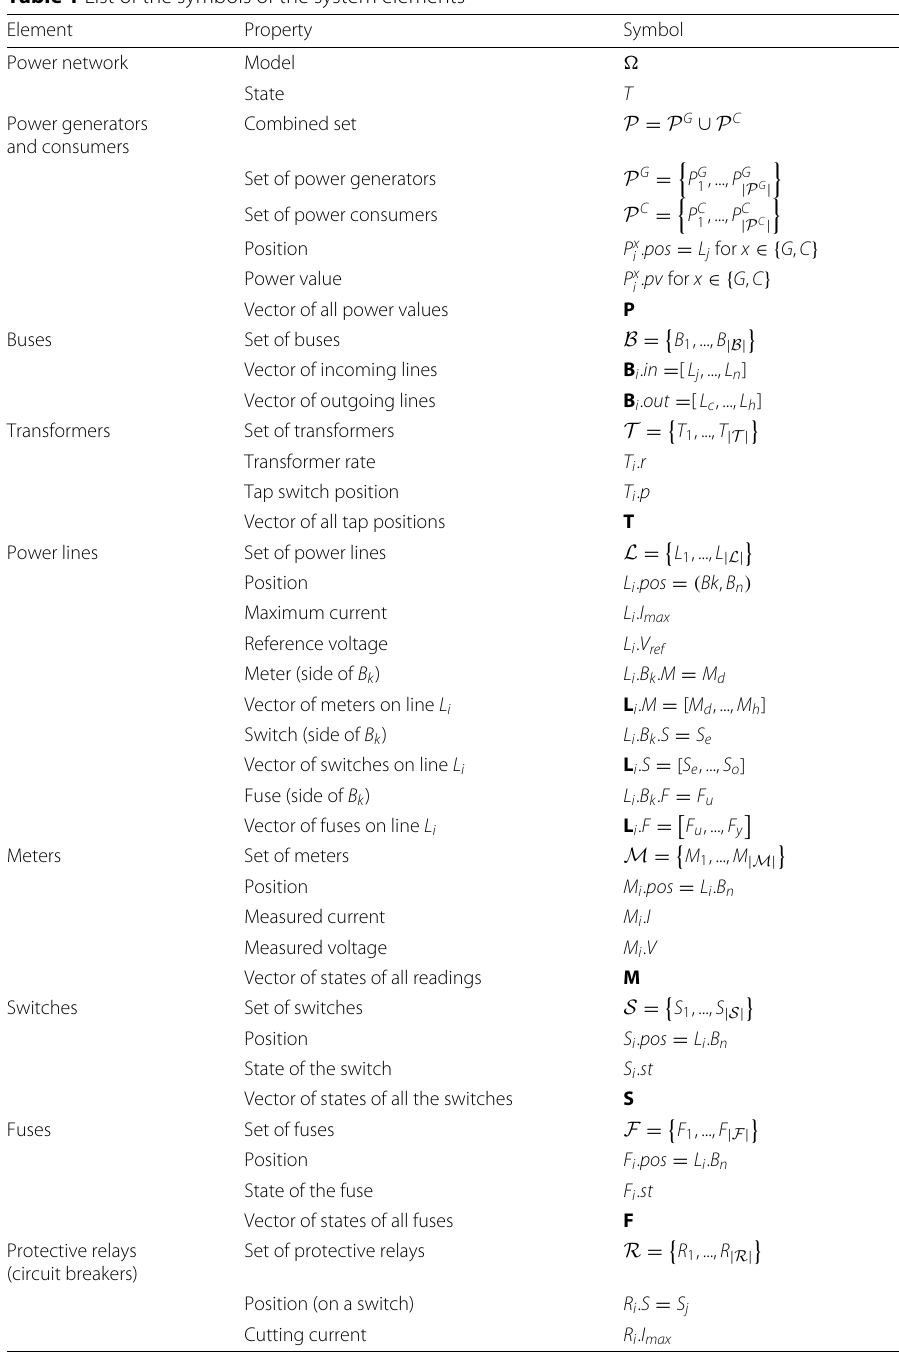
Table 1 List of the symbols of the system elements Element Property Symbol Power